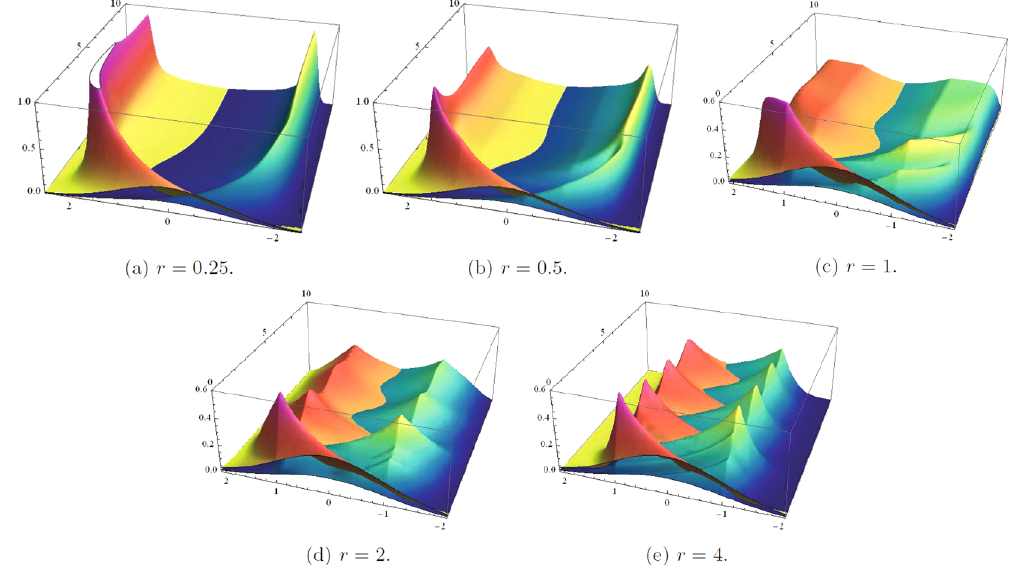
Figure 4. Evolution of the PDF for on/off (blue/red) states shown as a function of temperature, x ∈ [ − 2, 2], and time, t ∈ [0, 10]. The initial distributions are chosen to be Gaussian, with the devices split in a 0.7/0.3 proportion between the on/off states. τ = 1, κ =